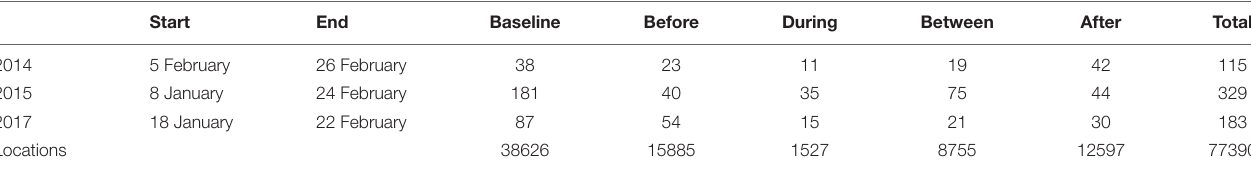
TABLE 1 | Timing, number, and duration of bouts of sonar activity during naval training activities in 2014, 2015, and 2017. Start of first End of last sonar Sonar bouts Duration of bouts sonar bout bout Total Mean (min)